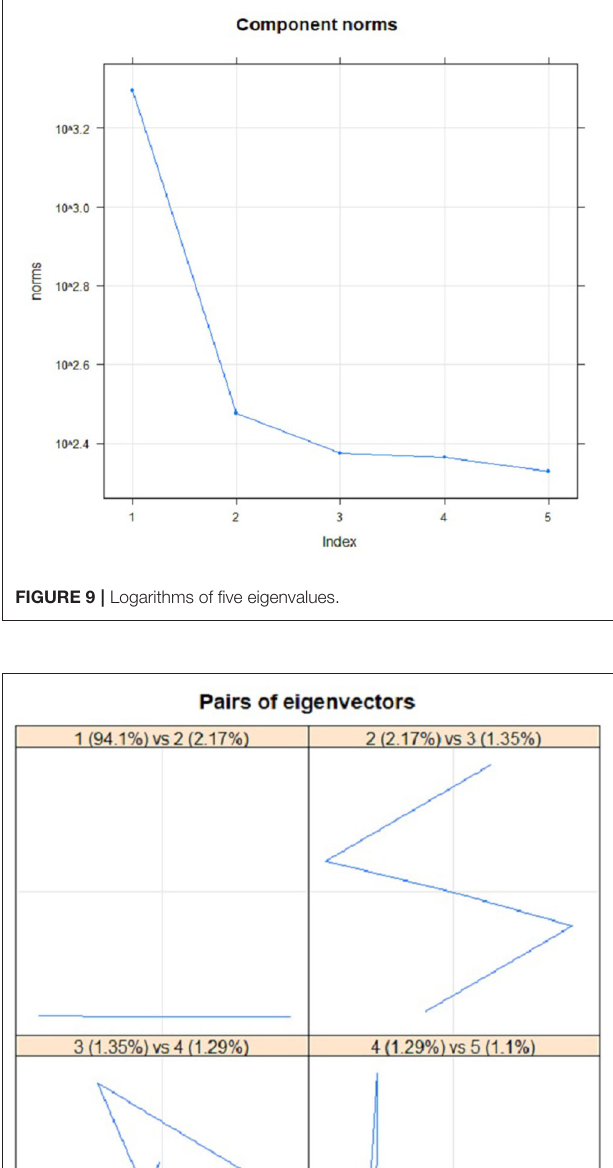
5, ET 2. 5, ET 1 (B) L = =